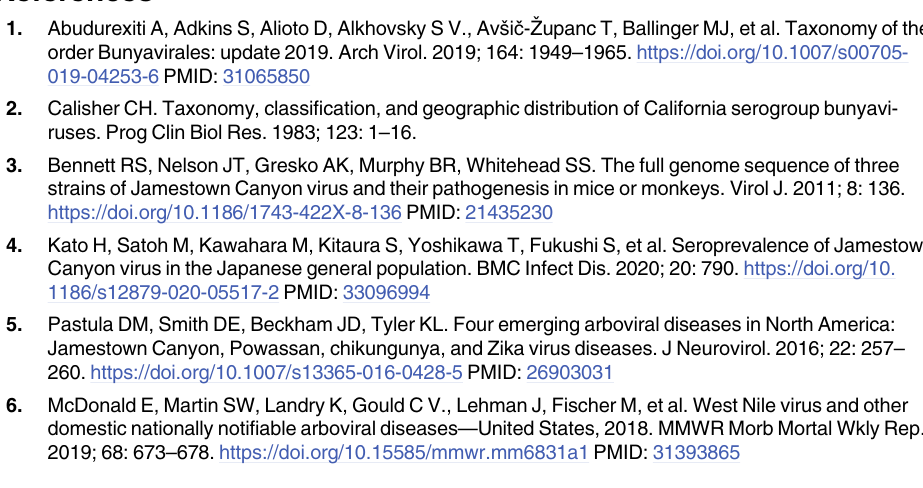
(pre-treatment) or (c, d) on the same day of viral inoculation (simultaneous-treatment) and continued for 5 days. The mice were treated intraperitoneally with FPV (300 mg/kg/day), RBV determined using the Kaplan-Meier analysis. The data of the single independent experiments are shown in each figure. S1 Table. Median survival time (day) of JCV-infected C57BL/6J mice treated with FPV, RBV, 2’-Fdc, and PBS in a single independent experiment. P-value was calculated using the log-rank